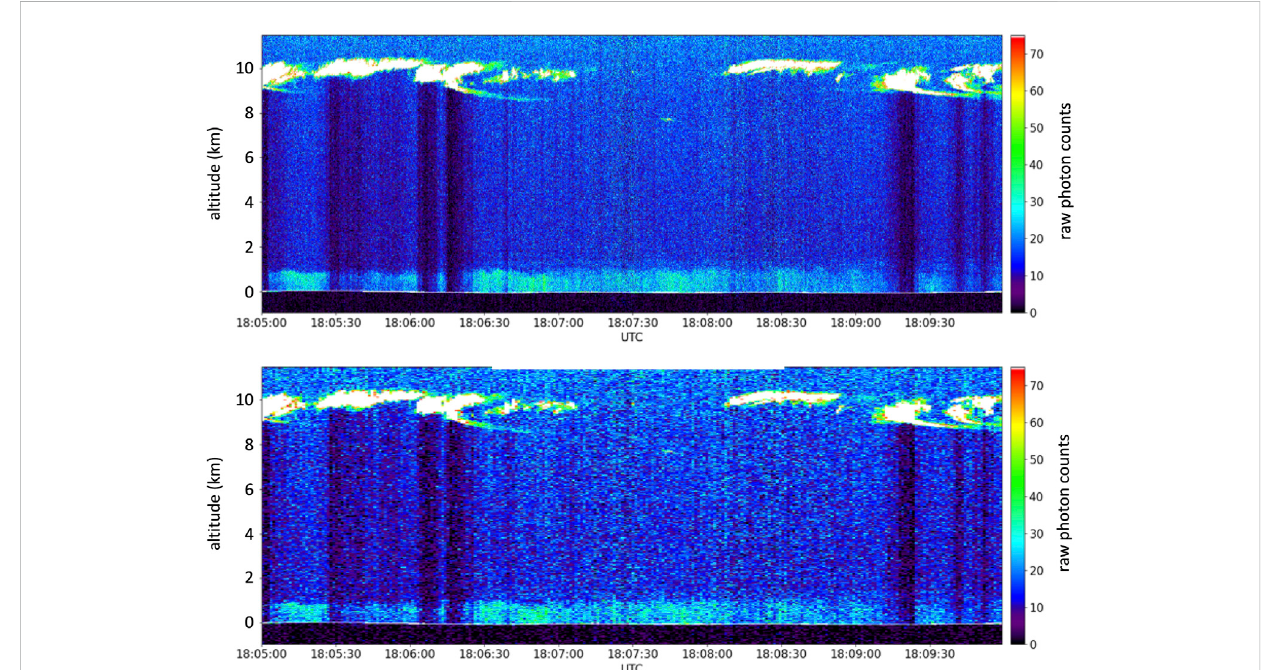
FIGURE 4 10-mindatasegmentfromneartheendofFigure2.Toppanelshows thefullrawdatavolume,withpro fi lessavedat10 Hz.Bottom panelshowsthe subsampled data volume, where a single 10 Hz pro fi le is transmitted each second. This is the data the AI/ML algorithm uses, at the native resolution (i.e., no averaging of pro fi